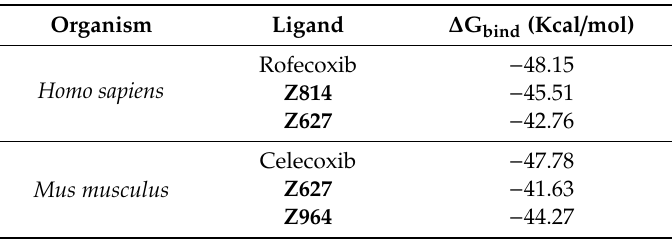
Table 14. A ffi nity energy of COX-2 ligands Table 14. Affinity energy of COX-2 ligands systems.